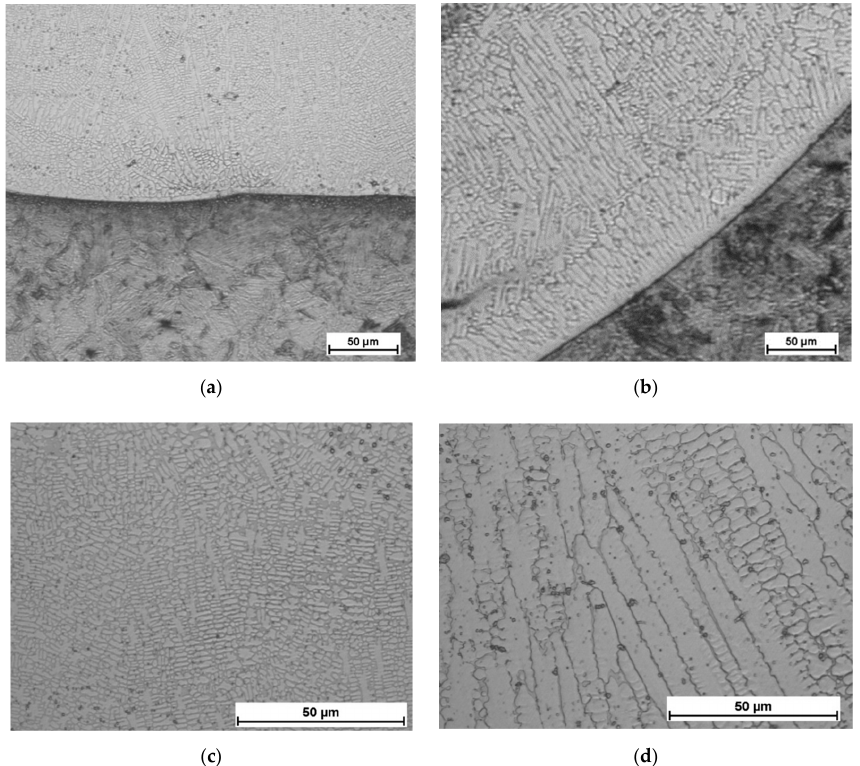
Figure 14. Microstructure of the comparative stringer beads LC4 and HC4 produced at the same process parameters (scanning speed 250 mm/min, laser output power 1000 W, energy input 240 J/mm) but different cooling conditions (Tables 3 and 5): ( a , c ) forced cooling under cryogenic conditions in a liquid nitrogen bath—interface region and middle region of the clad, respectively; and ( b , d ) free cooling in ambient air—interface region and middle region of the clad, respectively.